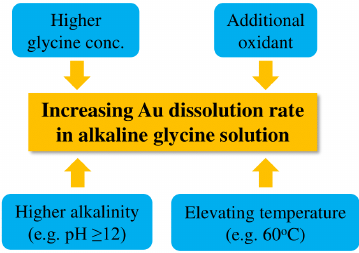
Figure 1. Number of publications regarding glycine leaching systems used to treat different solid resources since 2013 (data for 2022 is up to March 2022). Figure 2. Options to increase gold dissolution rate in alkaline glycine solutions (summarized from [12–14]).